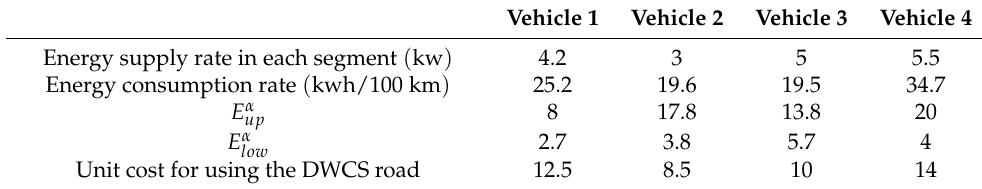
Table 1. Vehicle